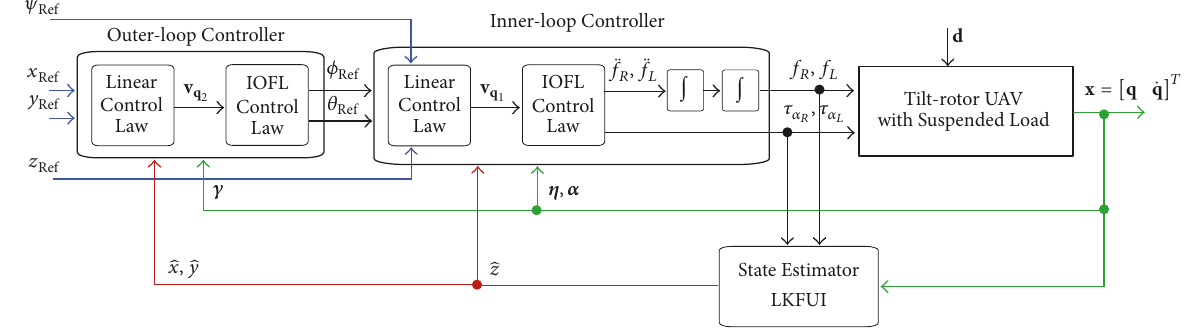
Figure 2: Nonlinear feedback linearization cascade control